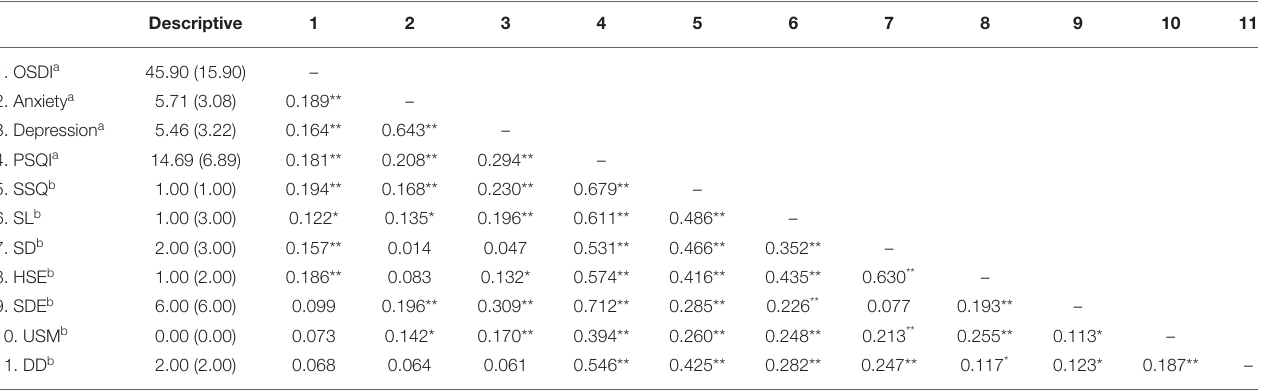
TABLE 3 | Descriptive statistics and intercorrelations between analyzed variables. Descriptive